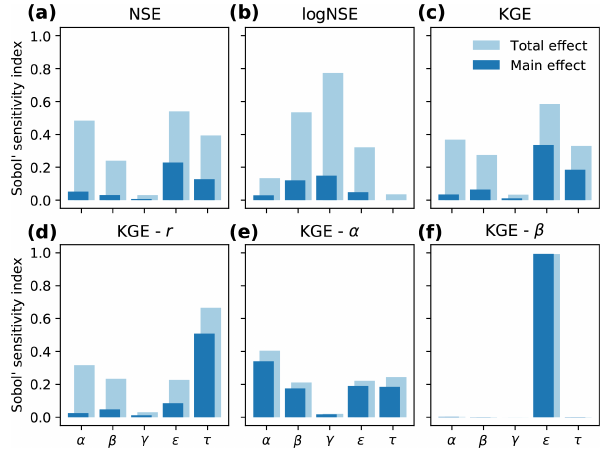
Figure 9. Sobol’ parameter sensitivity for a synthetic experiment, shown for different performance statistics. The main effect presents the sensitivity induced by that parameter alone, and the total ef- fect quantifies the sensitivity when parameter interactions are taken into account as well. The bottom row (d–f) shows the three compo- nents of the Kling–Gupta efficiency: Pearson correlation coefficient (KGE − r ), ratio of variability (KGE − α ) and bias (KGE − β ). plots. For each parameter combination, multiple